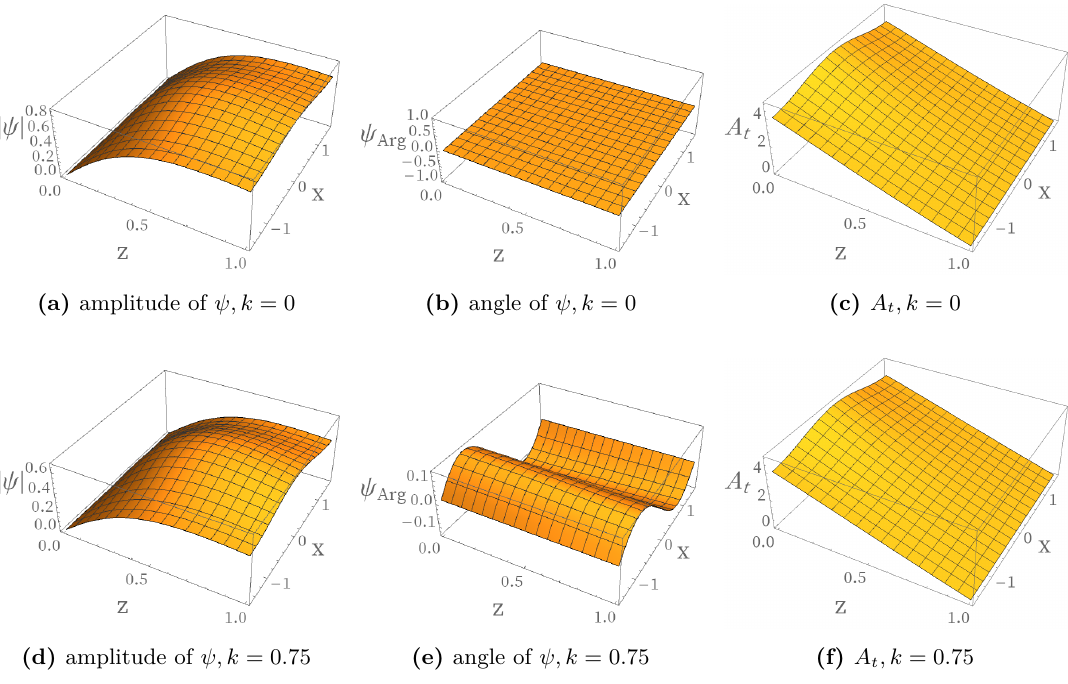
Figure 1. The amplitude and phase angle of the bulk field ψ are plotted in subfigures 1a, 1b, 1d and 1e; the bulk field A t is plotted in subfigures 1c and 1f. All the fields are calculated at k = 0 and 0 . 75